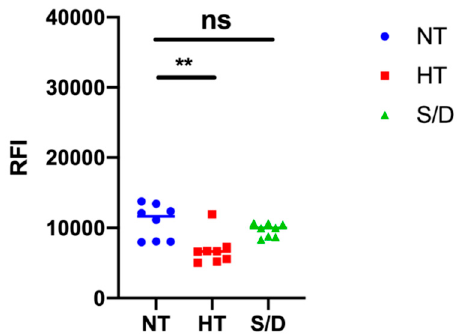
Figure 5. Results of immune-phenotyping by peptide microarrays of EVs isolated by ultracentrifu- gation from untreated (NT), heat treated (HT) and solvent/detergent (S/D) treated sera. EVs were captured by BP membrane binding peptide and fluorescently stained by a mixture of anti- CD9/CD63/CD81 antibodies. Significance level: p < 0.05; ** = p < 0.01.